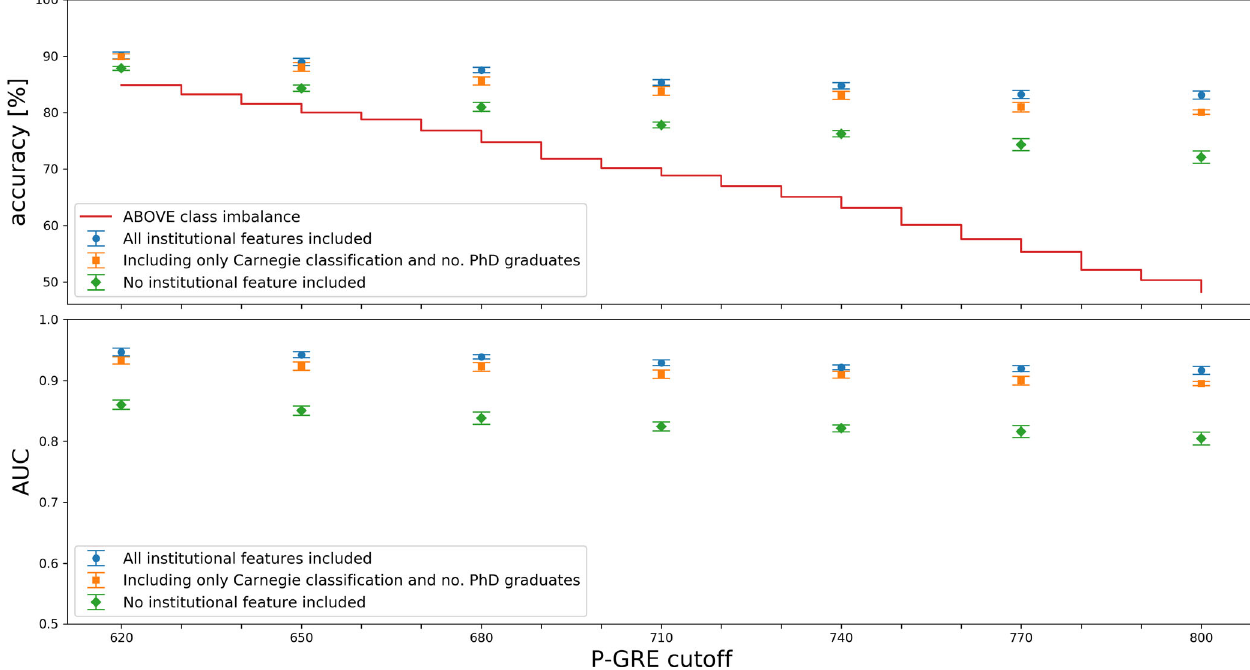
FIG. 7. Performance comparison between conditional inference forests with all features, with two institutional features, and without institutional features (only U-GPA, gender, and race). The standard errors of the K -fold ( K ¼ 10 ) estimates are indicated by the error bars. The significant improvement in performance by the simple addition of two institutional features suggests that the contribution from the institutional features is captured by a few